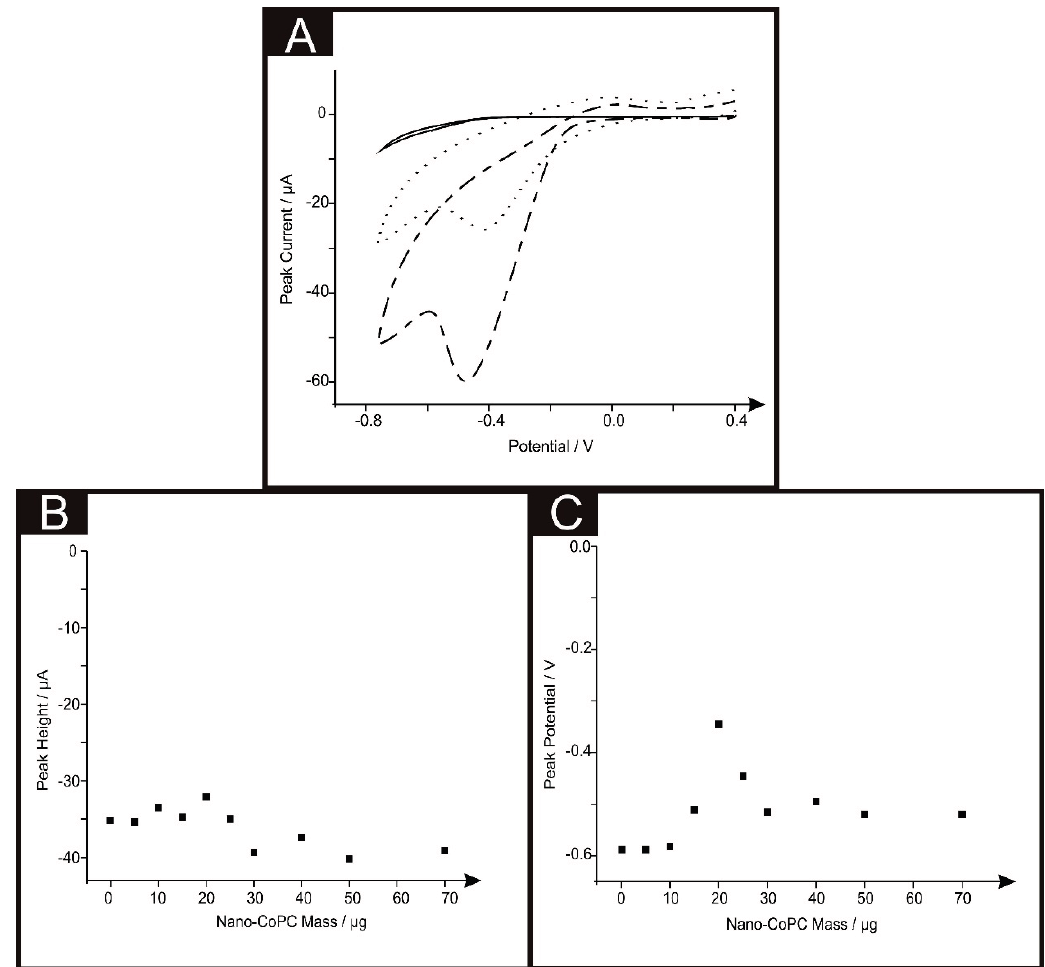
Figure 5. Cyclic voltammograms ( A ) recorded in an nitrogen degassed (solid line) and an oxygen saturated 0.1 M H 2 SO 4 solution utilising a standard-SPE (short dashed line), bulk-CoPC SPE (dotted line) and a standard-SPE modified with 20 µg nano-CoTAPC (dotted-dashed line). Corresponding plots of coverage of peak height vs. nano-CoTAPC mass ( B ) and peak potential ( C ). Scan rate: 100 mVs